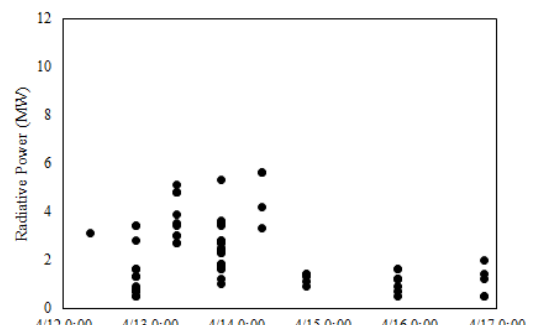
Figure 6 . Radiative power (MW) of fire pixels detected in west Chitwan, Nepal by VIIRS.